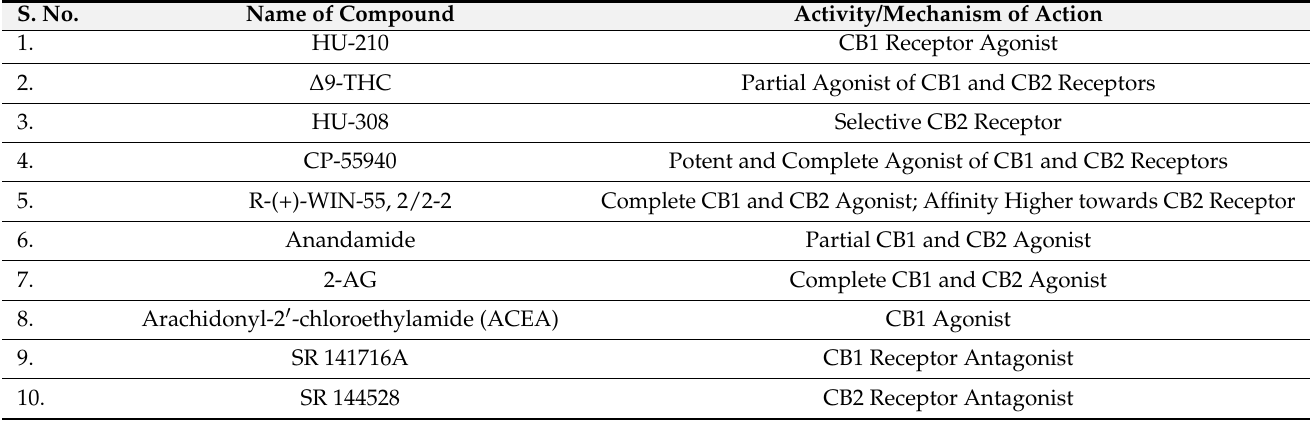
Table 1. The below table lists examples of the most commonly used compounds that act via endo- cannabinoid receptors and initiate numerous physiological